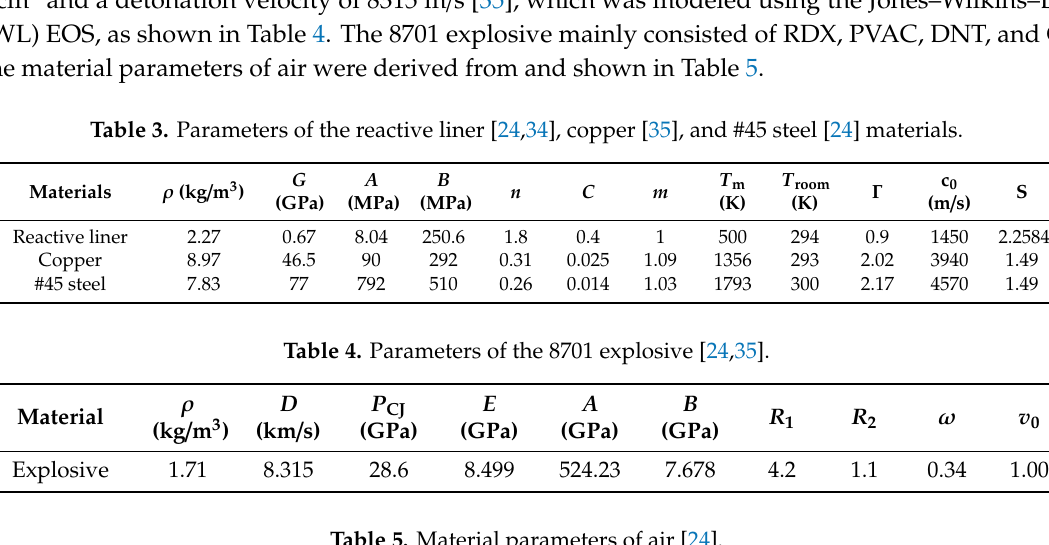
Table 5. Material parameters of air